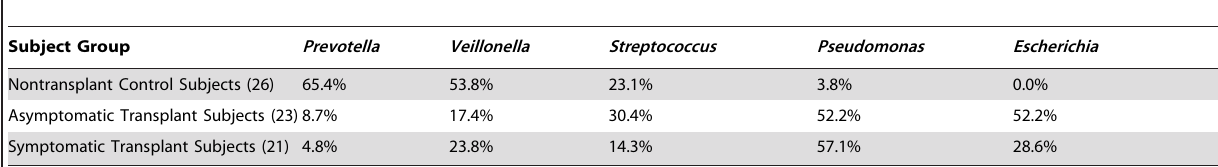
Table 5. Percentage of Subjects with . 10% Relative Abundance of Prominent Genera.